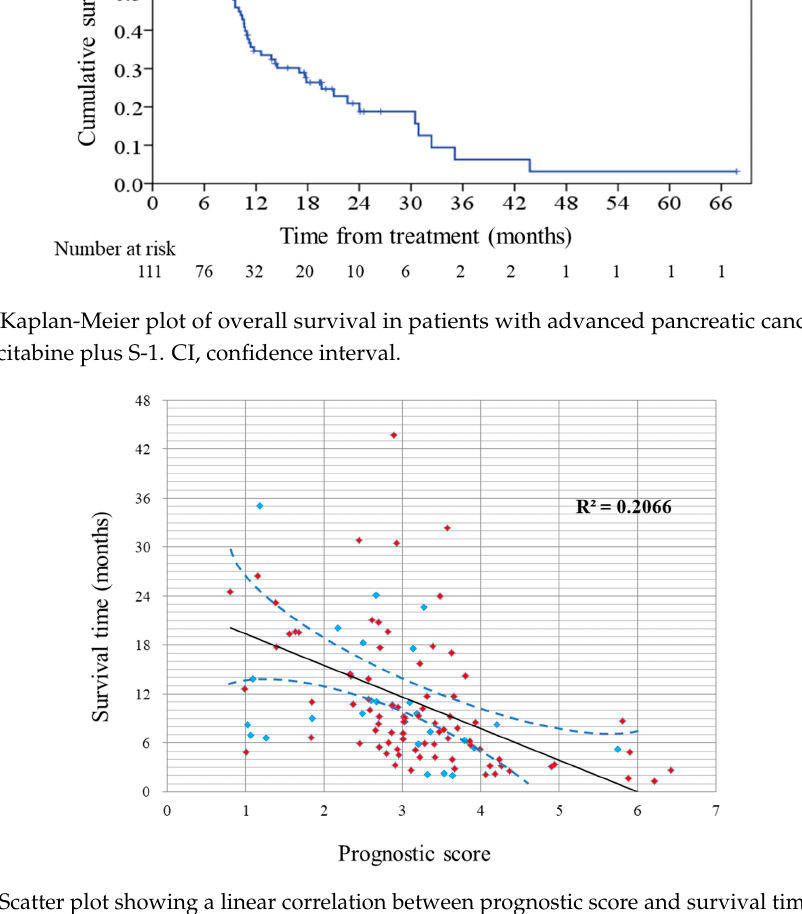
Table 3. β -coefficient of the prognostic factors defined by multivariate Cox modeling.